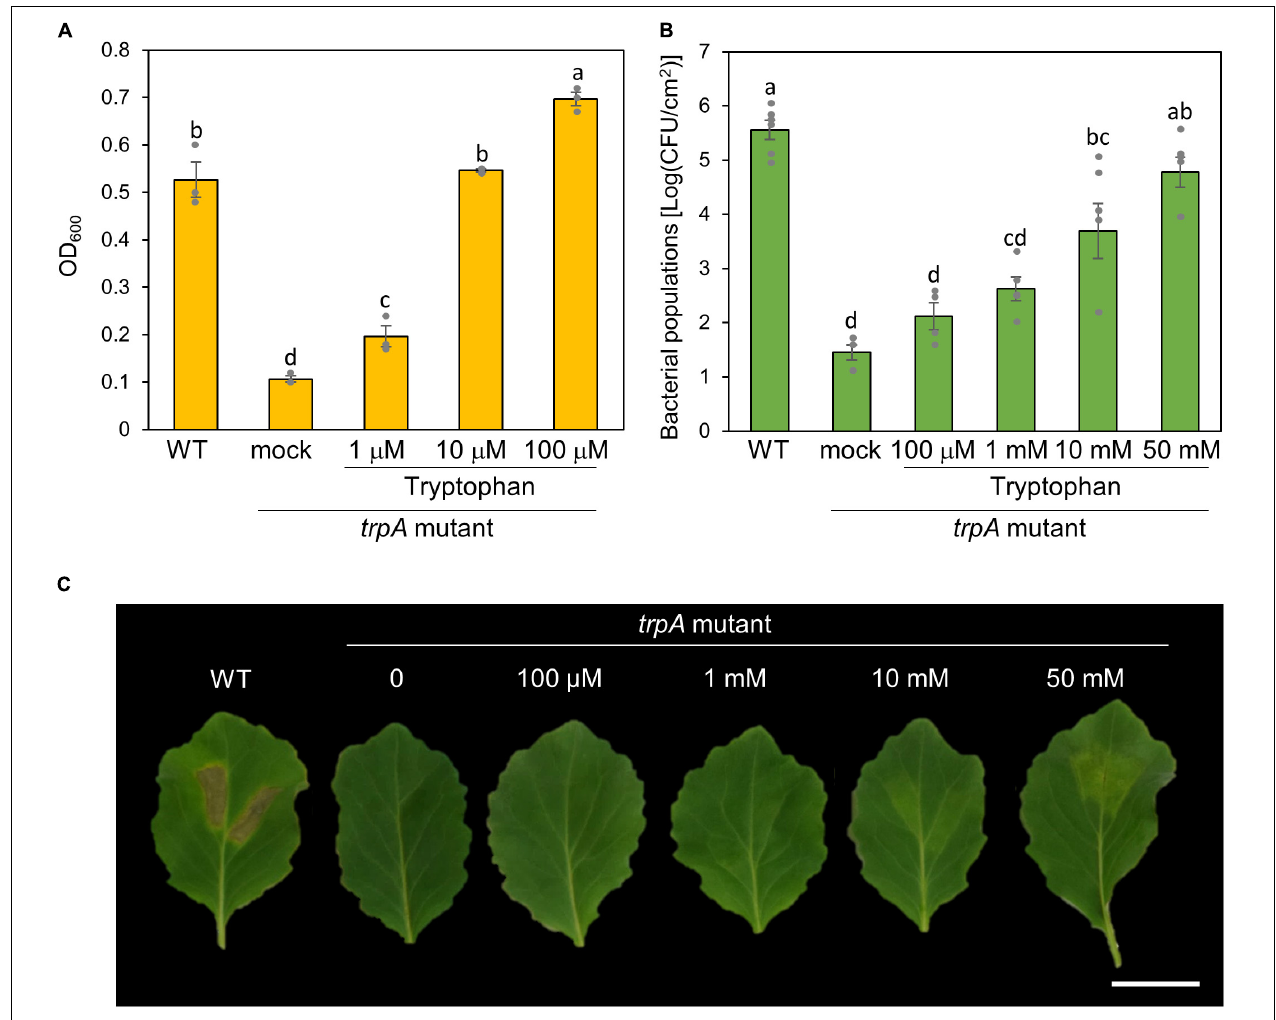
FIGURE 4 | Effect of exogenous tryptophan application on trpA mutant growth. (A) Growth of Pseudomonas cannabina pv. alisalnesis KB211 WT and the trpA mutant in MG medium. WT and the trpA mutant were adjusted to an OD 600 of 0.1 in MG medium. Additionally, the trpA mutant was co-incubated with tryptophan; 1, 10, and 100 µ M, respectively. Then, cultures were incubated with shaking at 28 ◦ C. Bacterial populations were quantified at 24 h. (B) Bacterial populations in cabbage syringe-inoculated with WT and the trpA mutant. Cabbage plants were syringe inoculated with 5 × 10 5 CFU/ml of WT and the trpA mutant. The trpA mutant was co-inoculated with tryptophan; 100 µ M, 1 mM, 10 mM, and 50 mM, respectively. Bacterial concentrations in the plant leaves were evaluated at 5 dpi. (C) Disease symptoms on cabbage co-inoculated with tryptophan. Cabbage plants were syringe-inoculated with 5 × 10 5 CFU/ml of WT and the trpA mutant. The trpA mutant was co-inoculated with 100 µ M, 1, 10, and 50 mM tryptophan, respectively. The leaves were photographed at 5 dpi. Scale bar shows 2